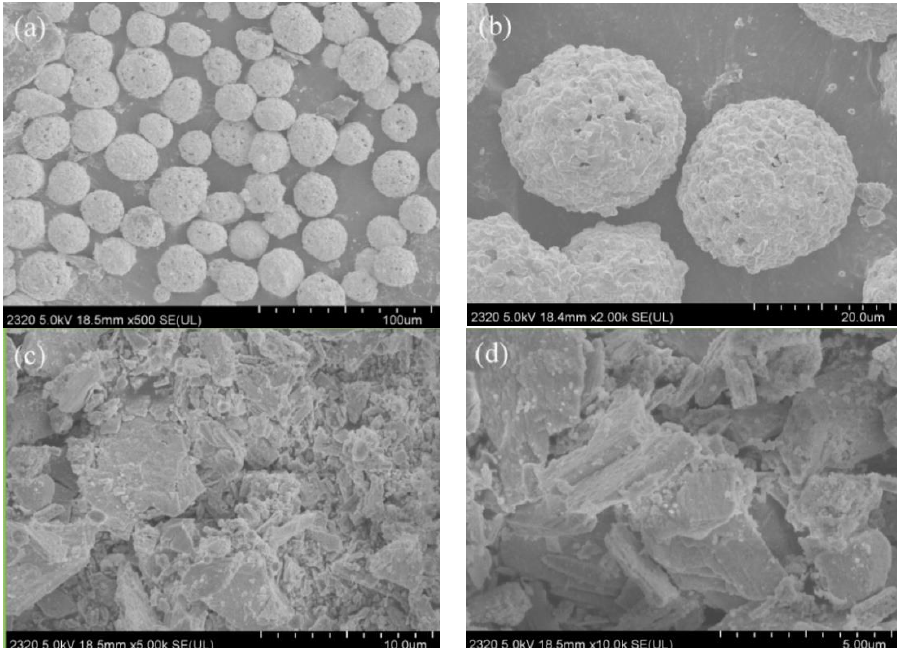
Figure 1. SEM image of WC-10Co-4Cr and CeO 2 powder: ( a , c ) low magnification; ( b , d ) high mag- nification.